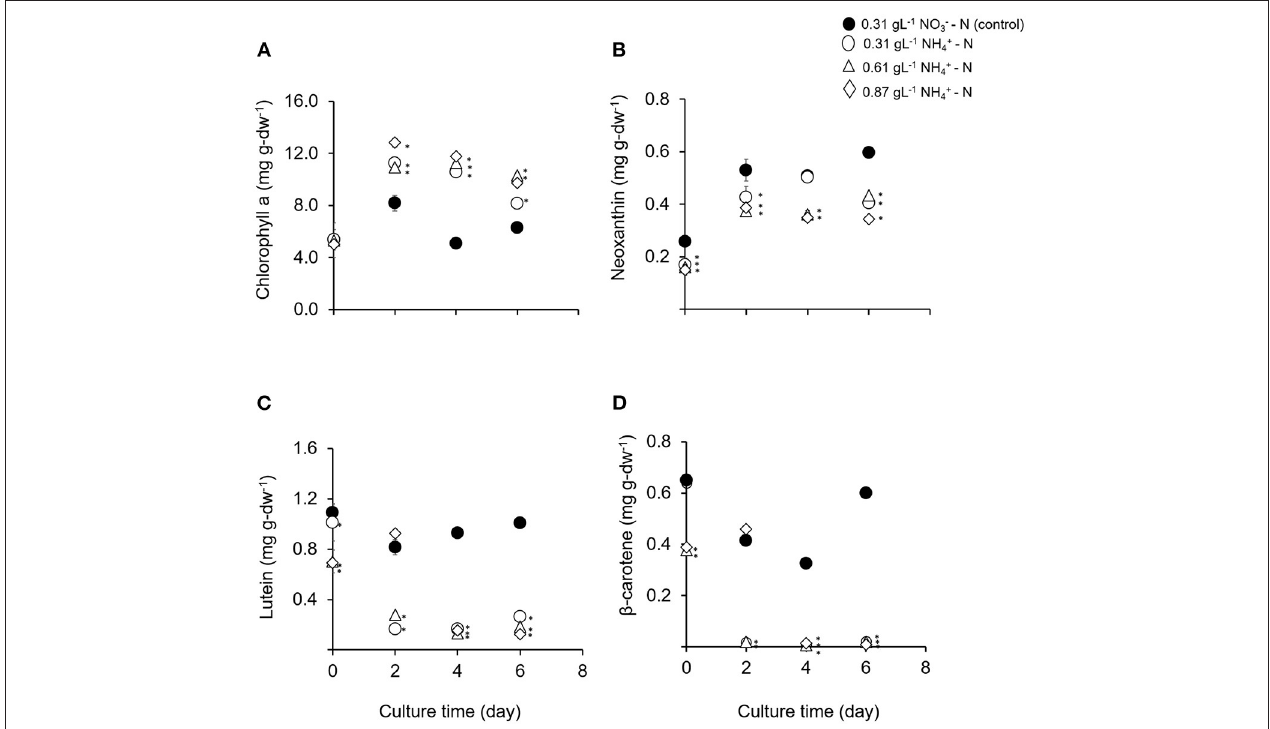
FIGURE 3 | (A–D) Means and standard deviations of phototrophic pigment production in T. tetrathele by using different concentrations of ammonia as nitrate act as the control. Points marked with an asterisk indicate significant difference between treatments on that specific day, p < 0.05. Values are means ± SD ( n =